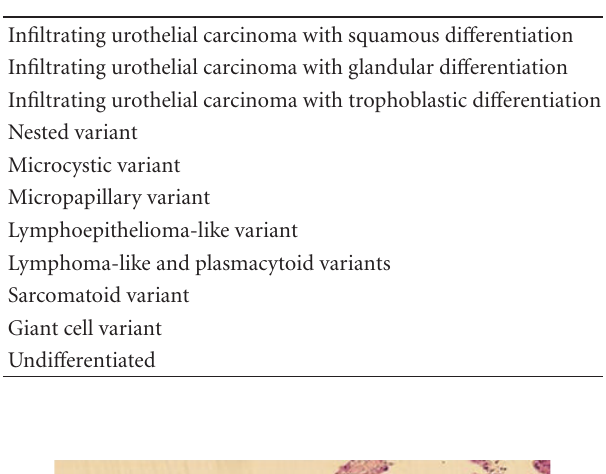
Table 1: Urothelial carcinoma and its variants.